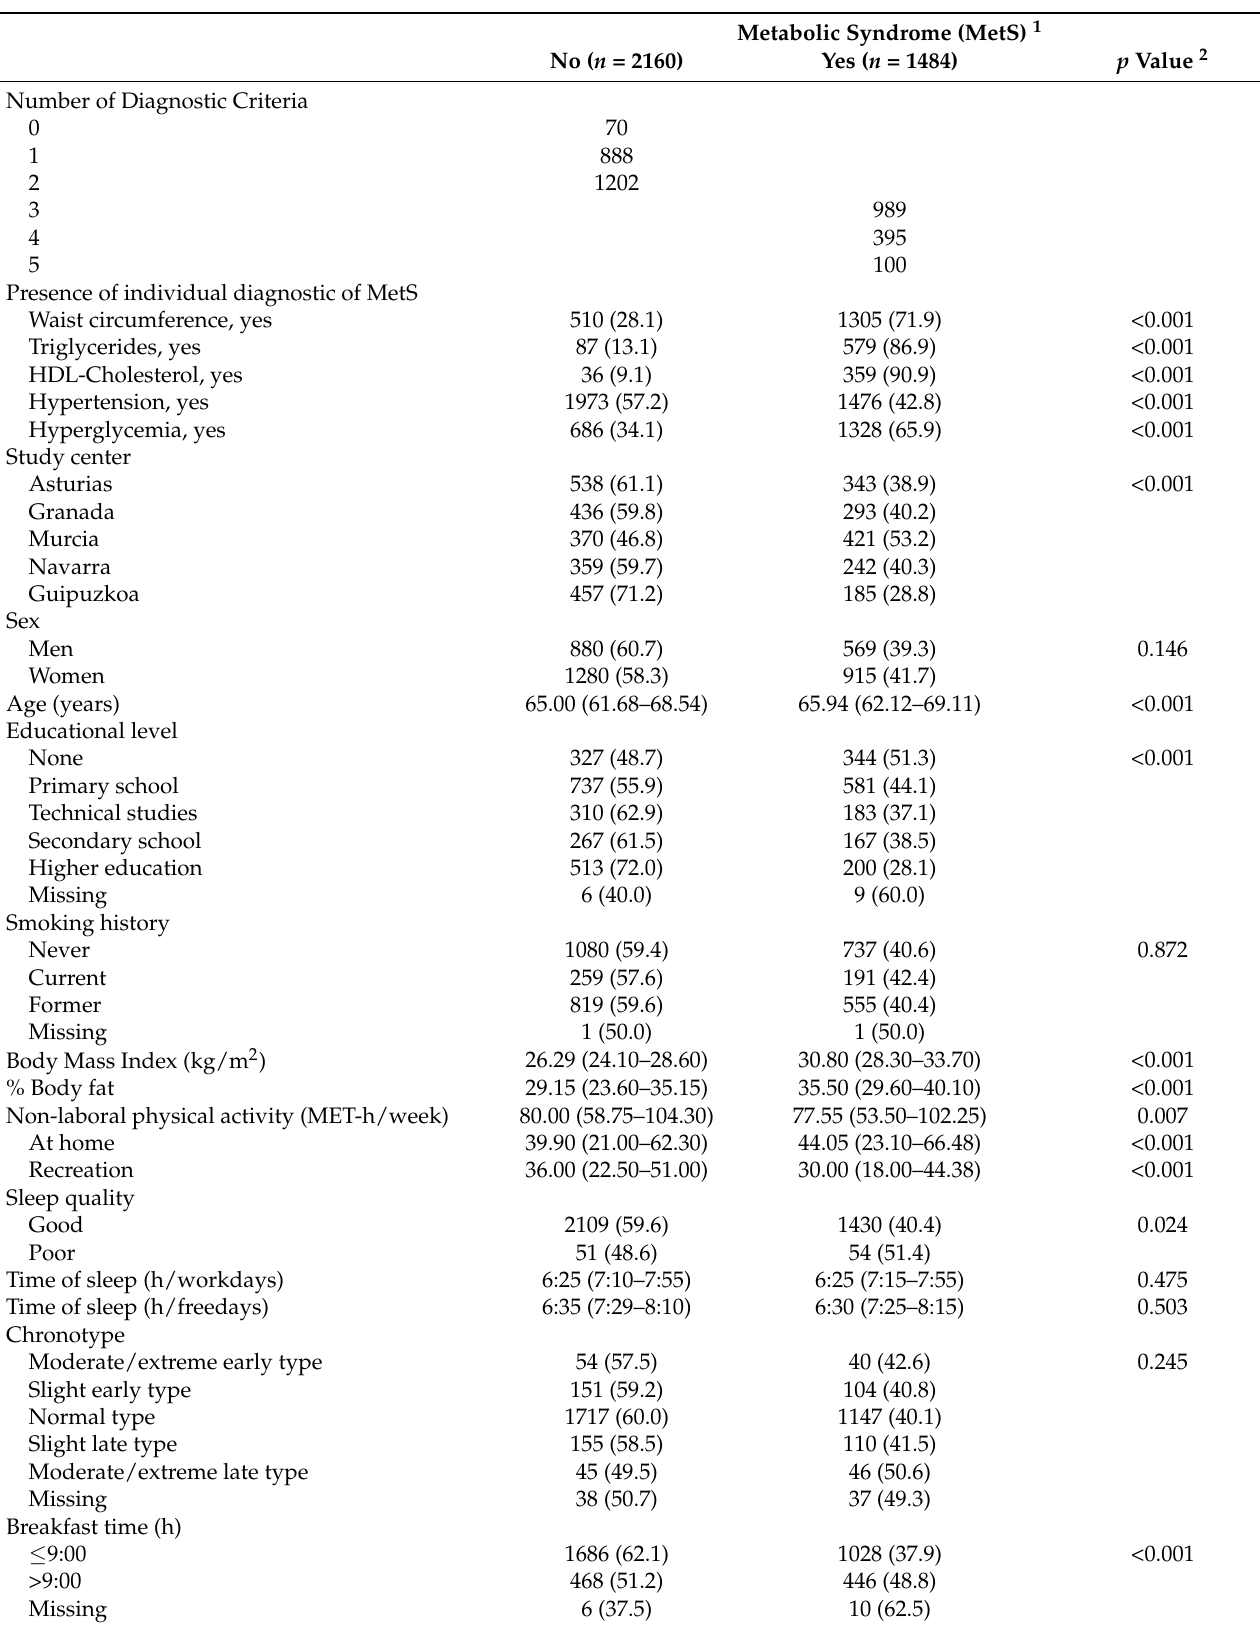
Table 1. Descriptive characteristics by Metabolic Syndrome